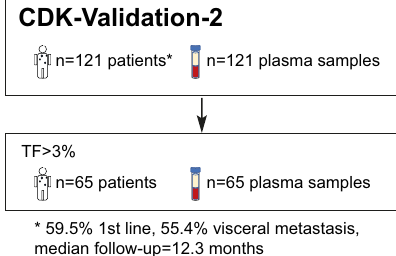
HR+/HER2- breast cancer treated with endocrine therapy and a CDK4/6 inhibitor (CDK-Validation-1 and CDK-Validation-1 cohorts). TF tumor